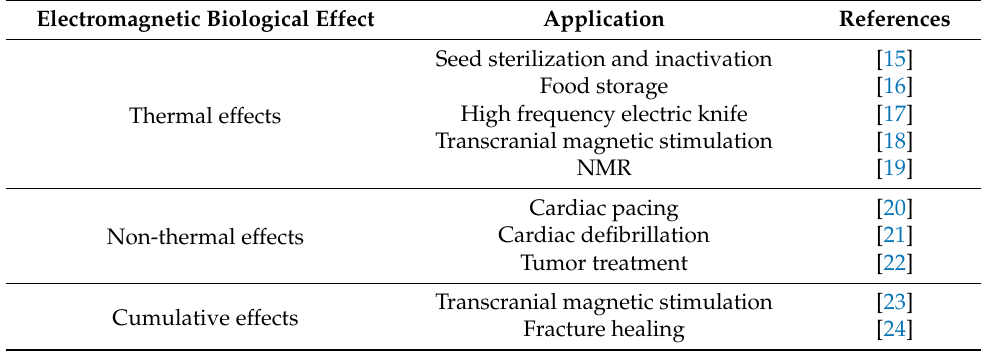
Table 1. Electromagnetic biological effects and related